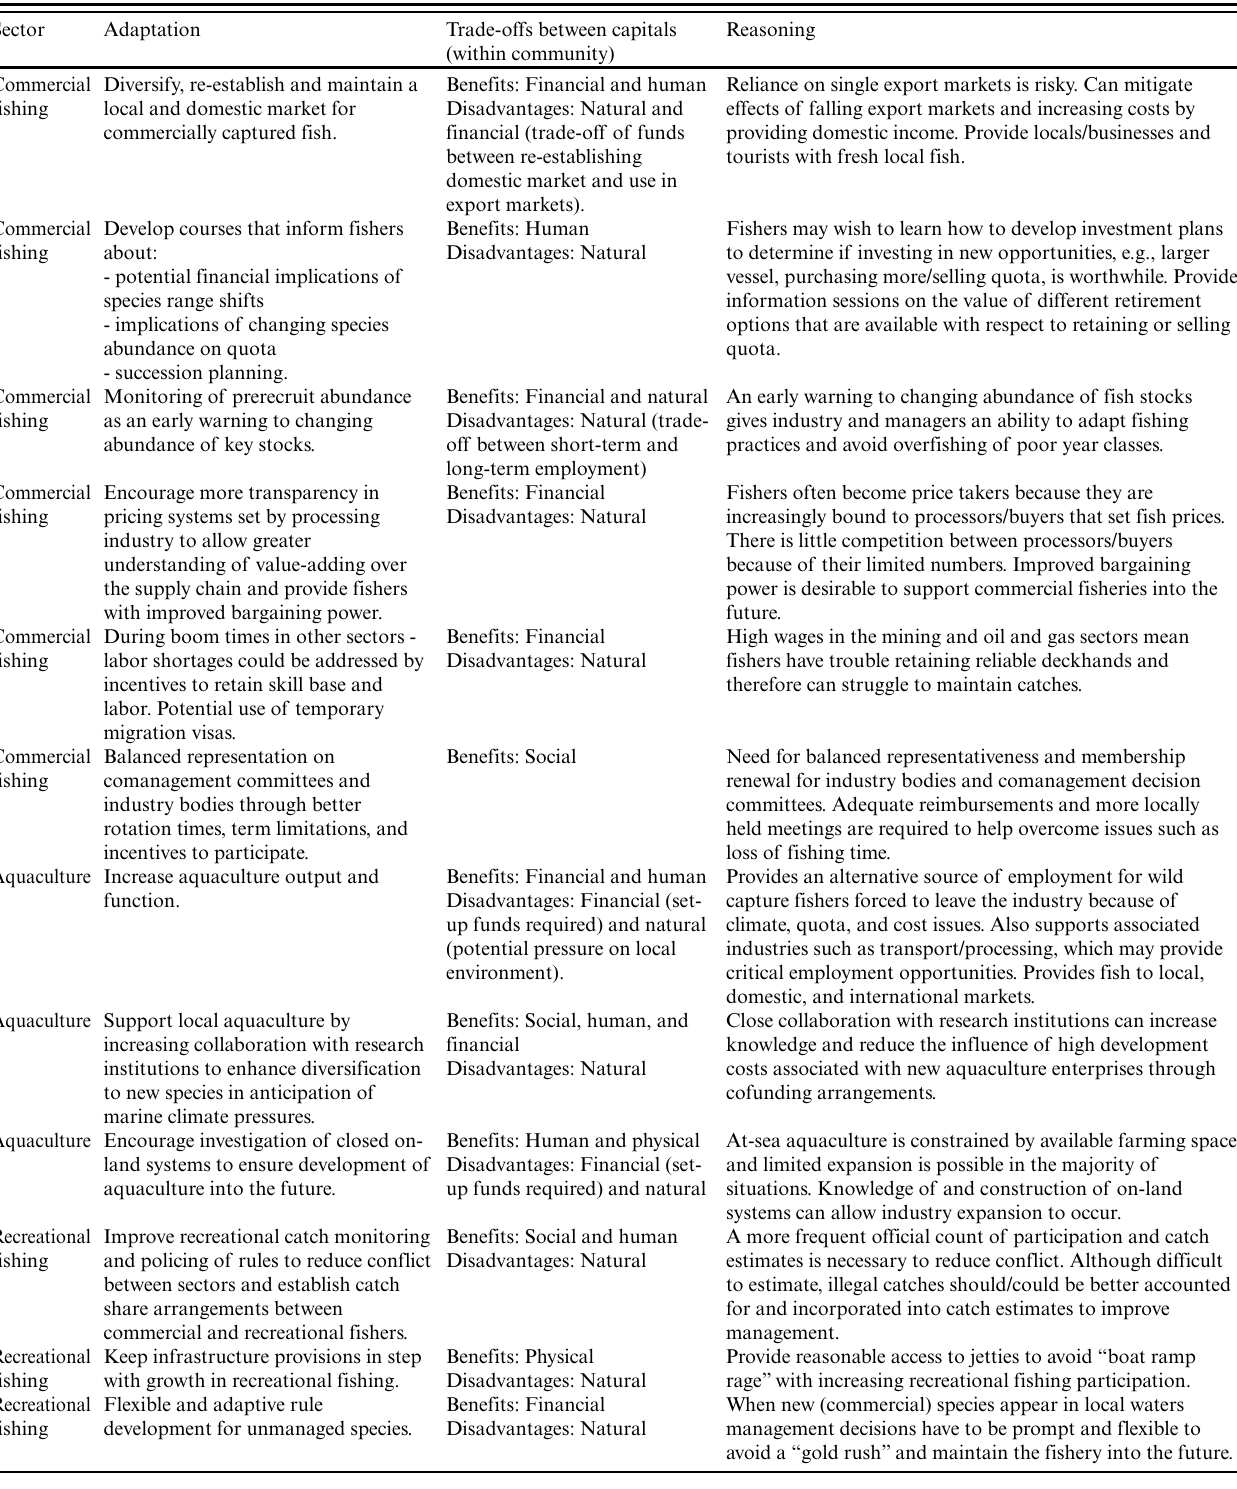
Table 8 . Adaptations, reasoning, and expected trade-offs identified for all case study